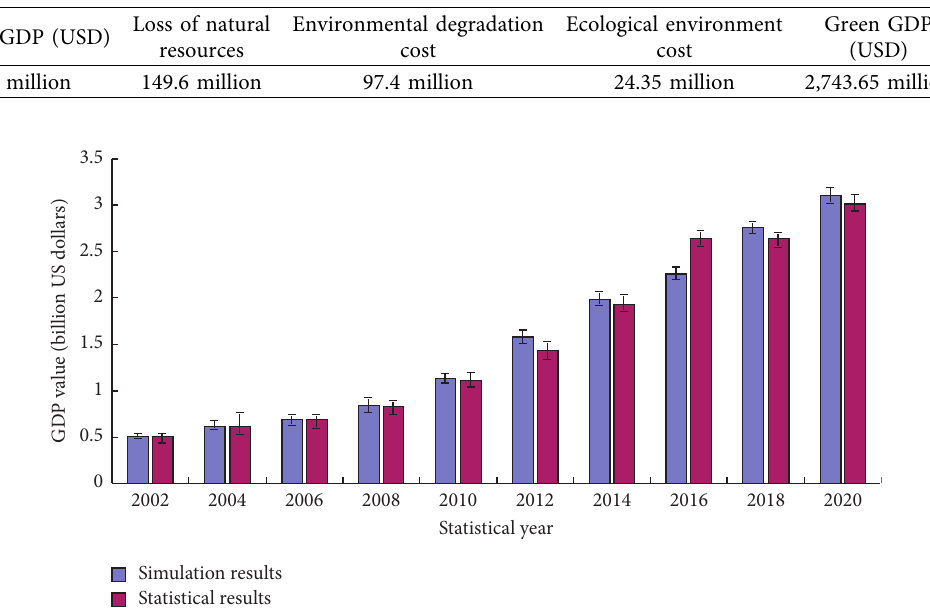
Table 3: Accounting results of green GDP in 2020.